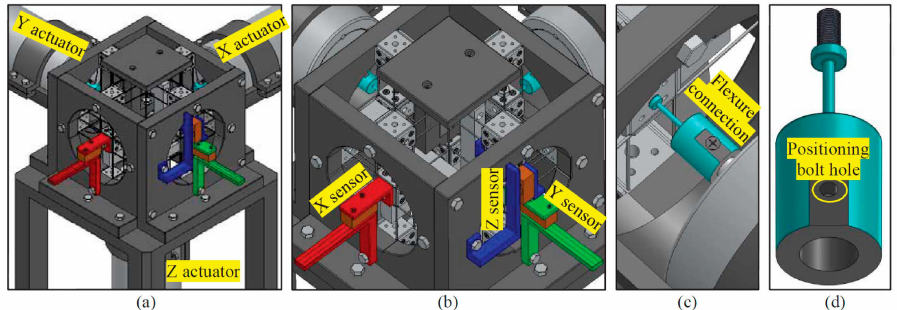
Figure 16. Demonstration of a spatial high-precision translational manipulator based on the practical design-I or design-II: ( a ) the spatial high-precision translational manipulator, ( b ) translational displacement measure sensor and ( c , d ) flexure actuator